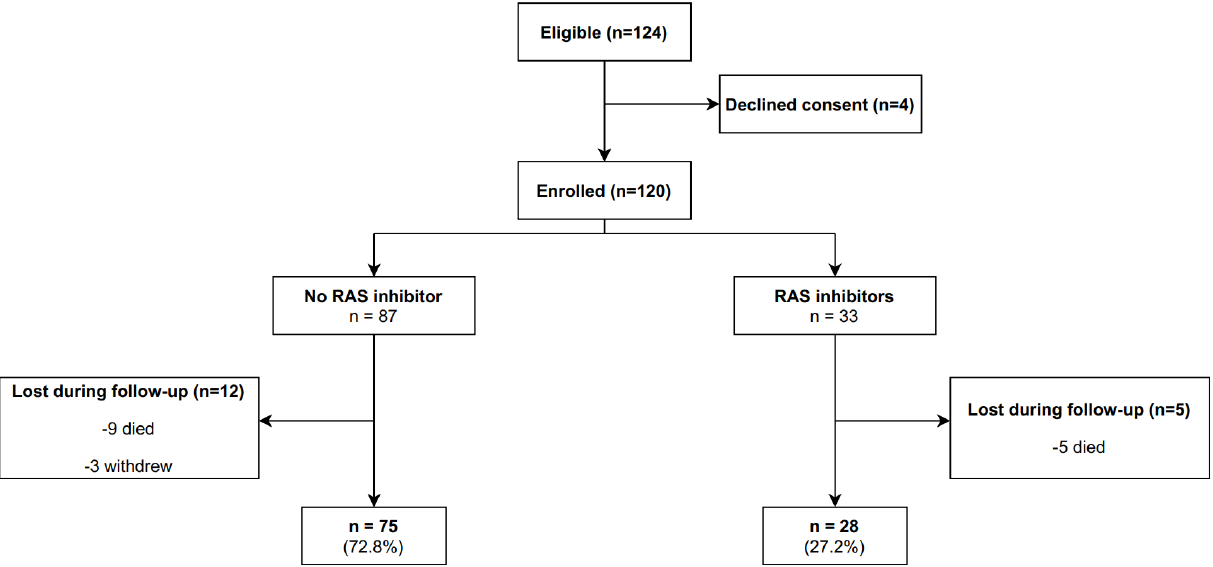
Figure 1. Flow diagram describing the recruitment and progress of participants in the cohort study. RAS: renin-angiotensin system.